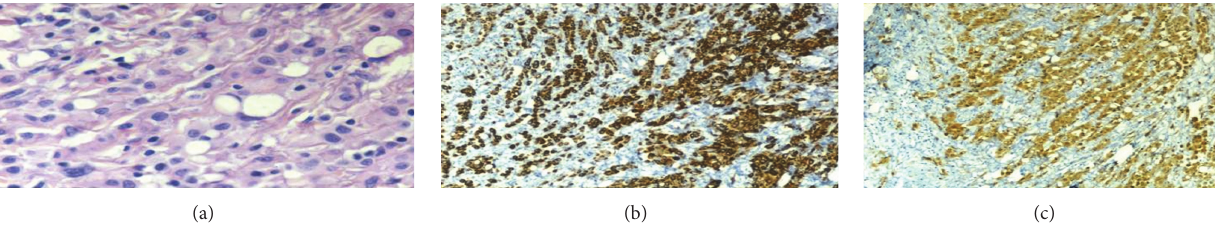
Figure 2: Histological examination of pericardium. The tumor cells are large polygonal cells with prominent nuclei and cytoplasmic vacuoles (Hematoxylin and Eosin staining, × 40) (a). Strong diffuse staining of mesothelioma cells with Cytokeratin 5/6 ( × 10) (b). Calretinin staining is strongly positive in tumor cells ( × 10)